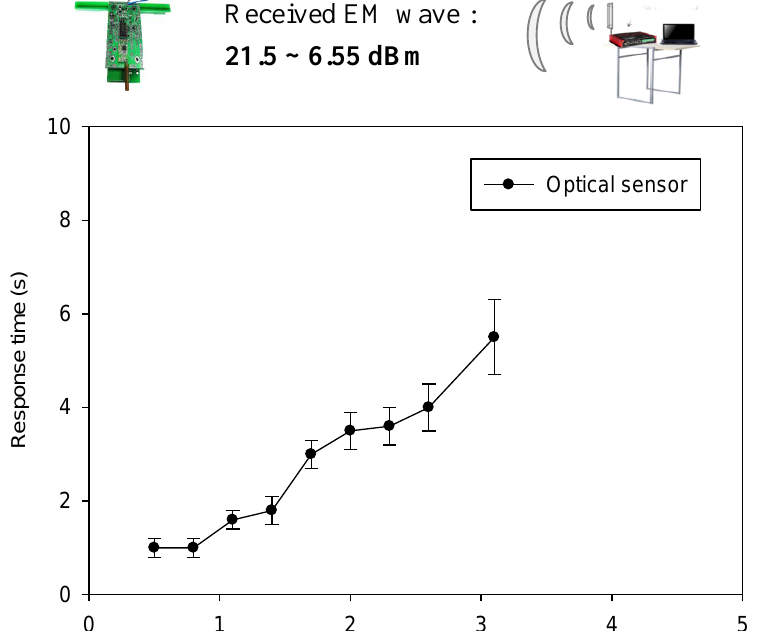
Figure 19. Response time of a WPWS equipped with optical